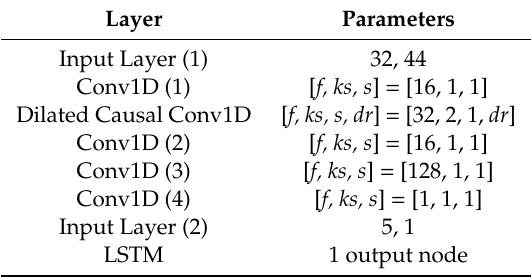
Table 1. Forecasting result obtained using dataset 1.